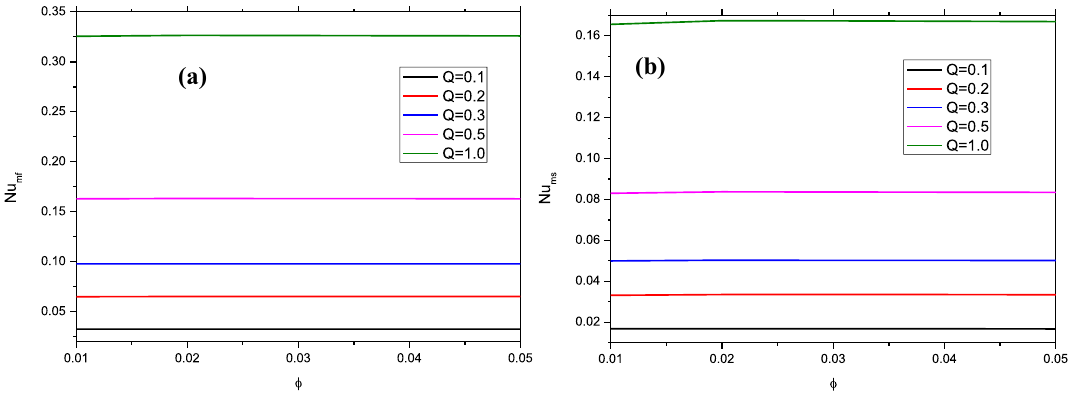
Fig. 7 Heat generation heat transfer parameter profiles of the average Nusselt number of fluid phase (top) and solid phase (bottom) for TiO –Cu/water Hybrid Nanofluid at Ha = 10 , Da = 10 – 3 , Ri = 1 , Gr 2